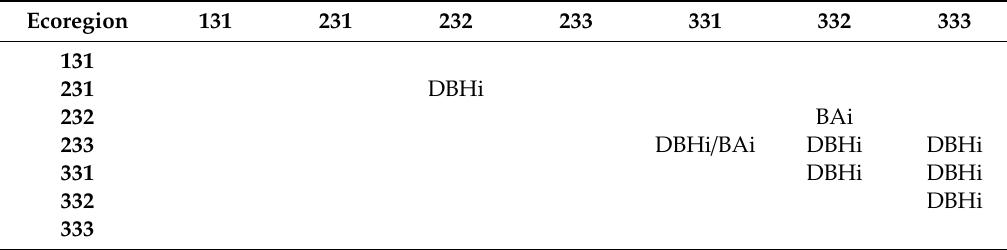
Table 4. Impact on growth of Norway Spruce by ecoregions assessed with the estimated marginal means. Ecoregions not significantly di ff erent are identified for DBH increment and basal area increment with DBHi or BAi, respectively. The empty cells indicate significant di ff